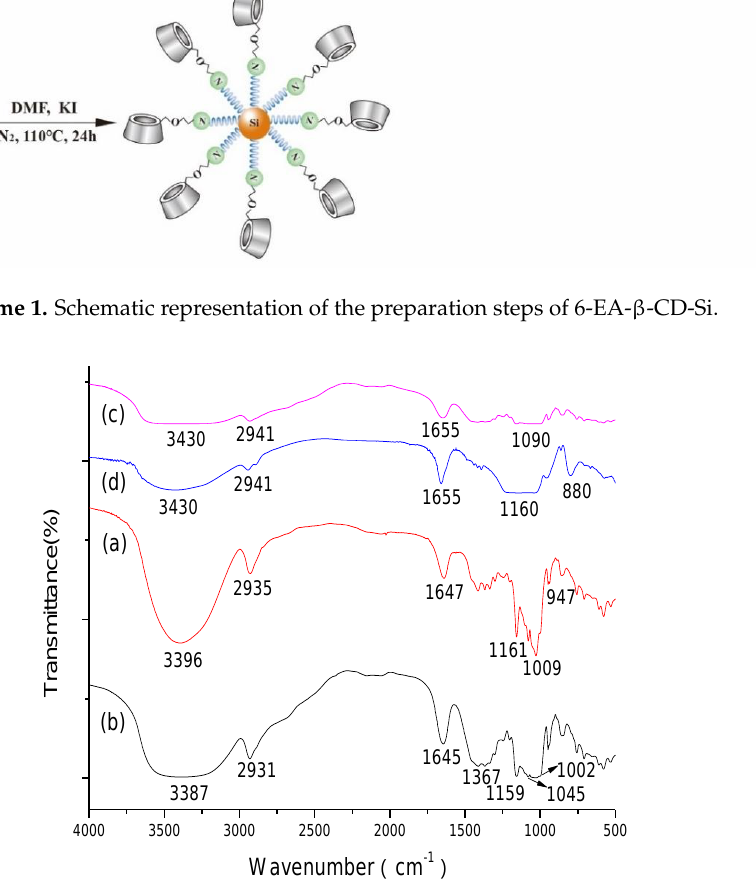
Figure 1. Fourier transform infrared (FT-IR) spectra of β-CD (a), 6-EA-β-CD (b), Cl-Si (c), and 6-EA-β-CD-Si (d).